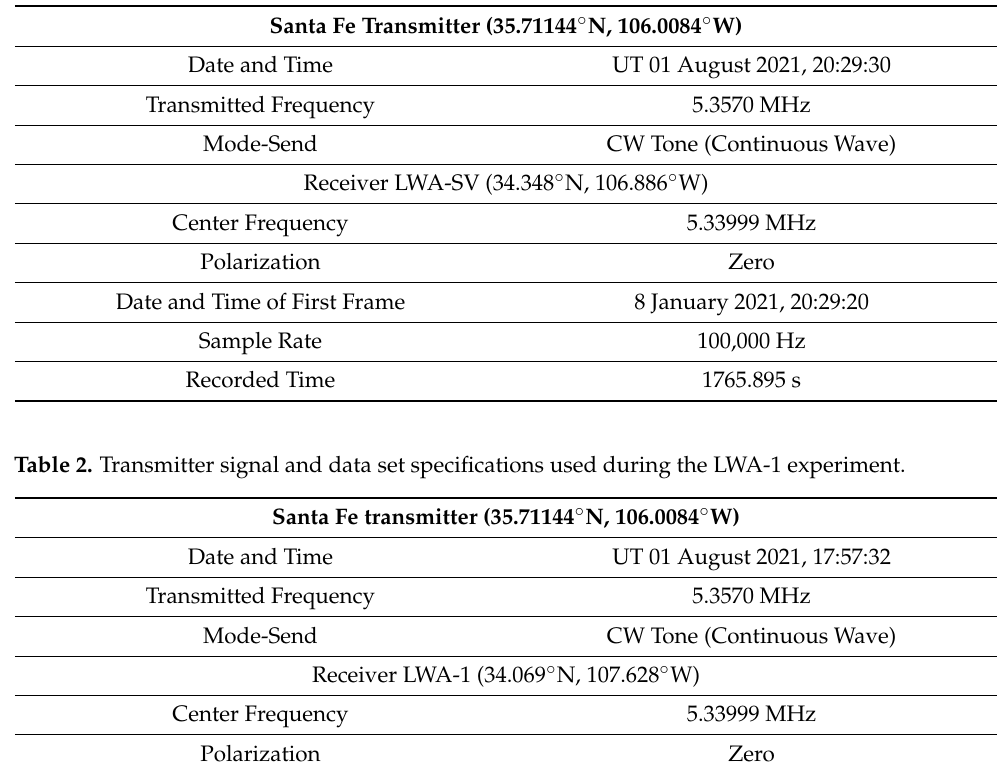
Table 1. Transmitter signal and data set specifications used during the LWA-SV experiment.